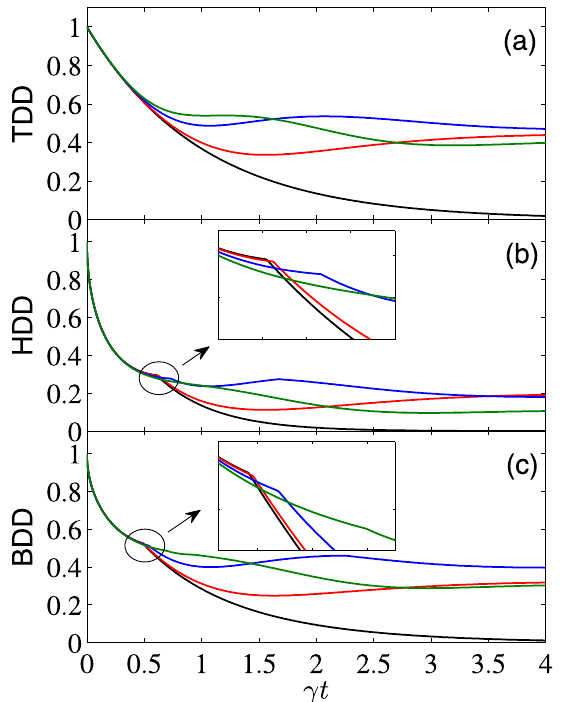
Figure 2. γ t dependence of TDD, HDD, and BDD (in units of J ) for the initial state φ + , with = n 0 , B = 0, and Δ = 0 (black), 0.3 (red), 0.7 (blue), and 1 (green). Moreover, the black line overlaps with that for noninteracting qubits.